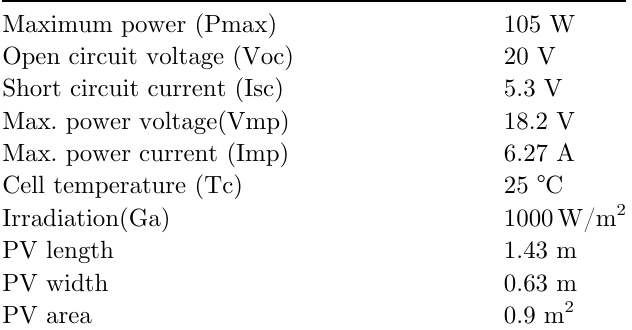
Table 2. The used PV modules speci fi cation. Maximum power